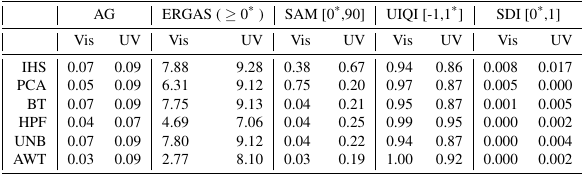
Table 4: South Ray: Average values of performance metrics